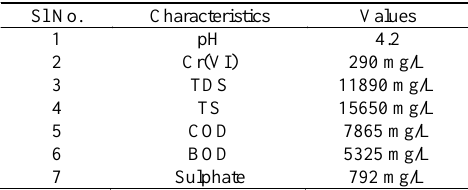
Table 1: Characteristics of tannery industry wastewater Sl